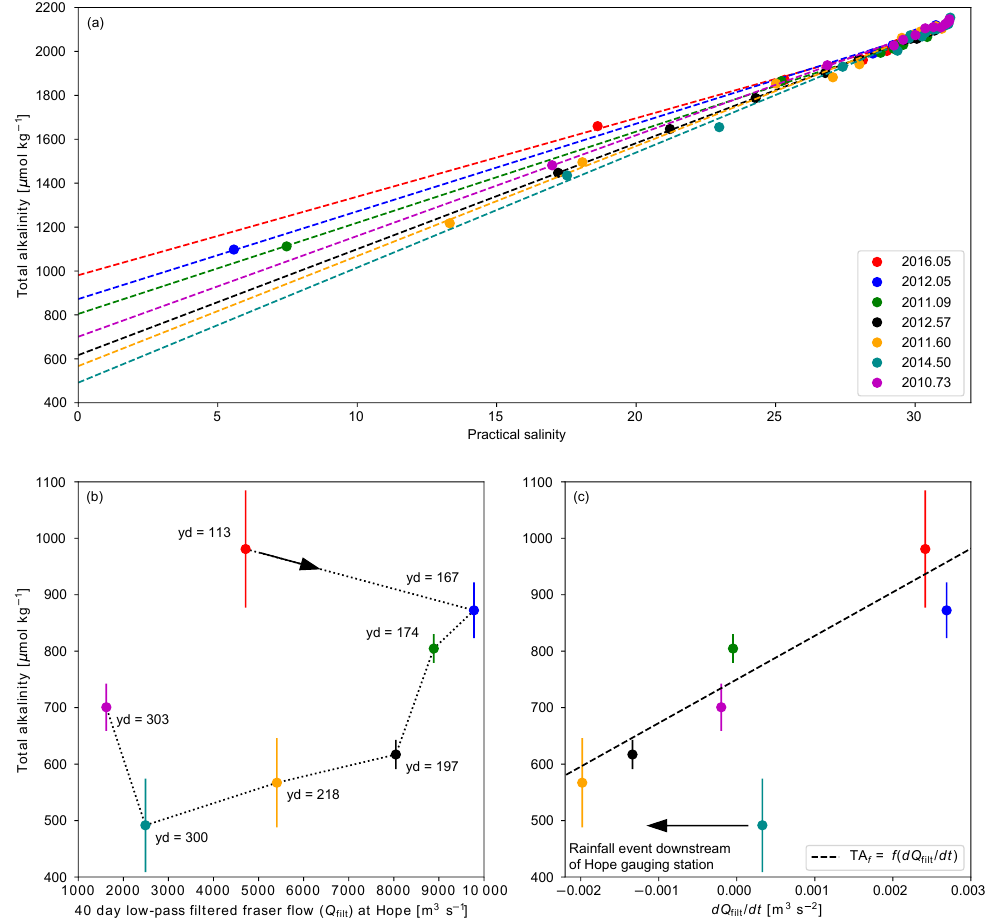
Figure 2. (a) Observed TA versus salinity ( S ) (circles) and linear regressions (dashed lines) from seven Department of Fisheries and Oceans Canada (DFO) Strait of Georgia cruises in the Fraser River plume (Ianson et al., 2016, Table S1 in the Supplement), (b) TA extrapolated to S = 0 versus low-pass filtered (40-day cutoff) Fraser River discharge ( Q filt ) at Hope (circles) plotted in sequence of year day (yd) as indicated by the dashed line and labels, and (c) TA extrapolated to S = 0 versus Q filt / d t (circles) with the flow-dependent freshwater TA parameterization used in this study (Eq. 1) overplotted (dashed line). Cruise ID numbers (legend) begin with the sampling year. Each cruise contains at least one data point at S <20. Error bars (b, c) are the 95% confidence intervals associated with the extrapolation to S = 0 using linear regression (a)